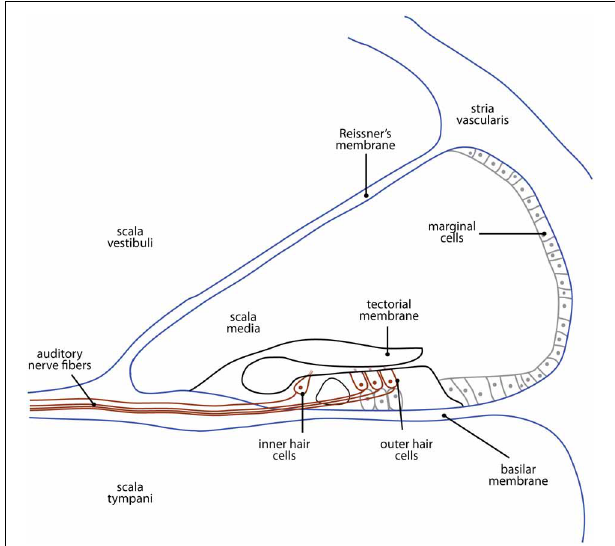
FIGURE 2 | A cross-sectional illustration of the cochlea showing the structures most commonly affected in animal models of deafness. The etiology of hearing loss depends on the type of model used, and is described in detail in the section titled The Cochlea and Cochlear